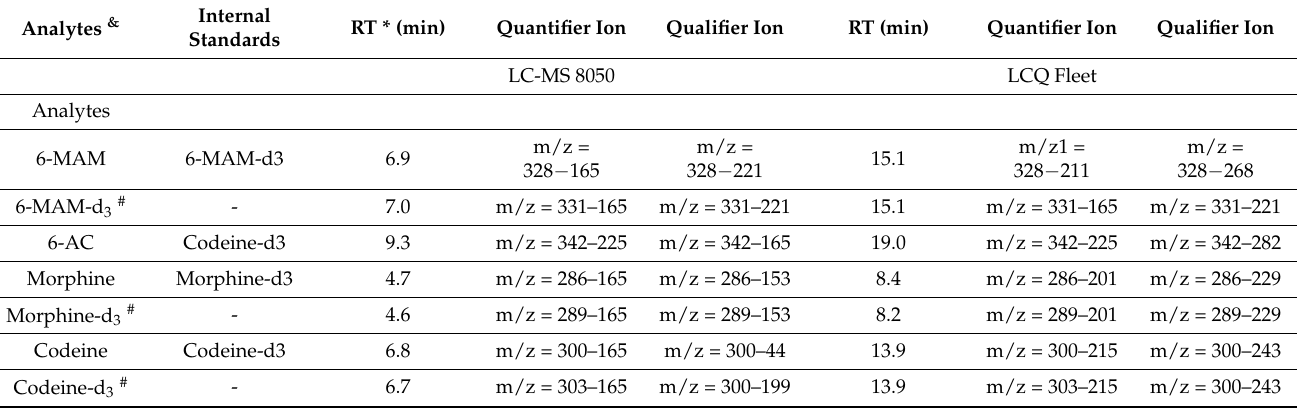
Table 1. Liquid chromatography electrospray ionization tandem mass spectrometry (LC-MS/MS) data for heroin biomarkers, morphine, and